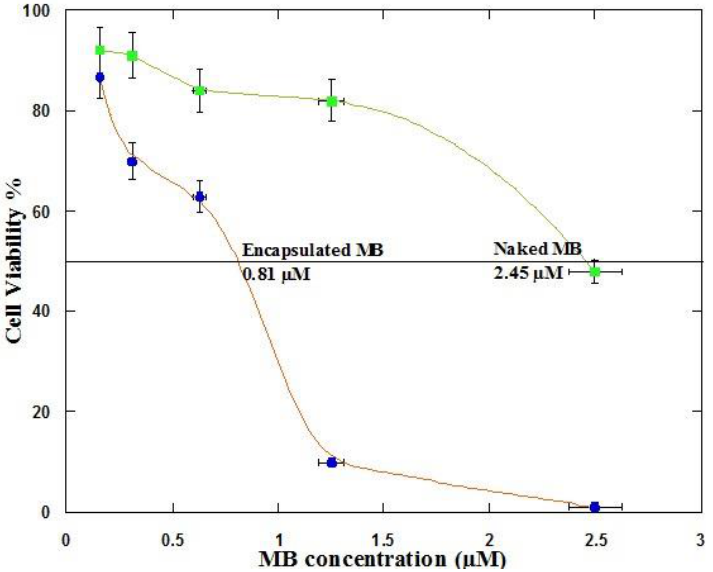
Figure 6. The ratio of percentage cell death under light irradiation to that without light irradiation for encapsulated and naked MB